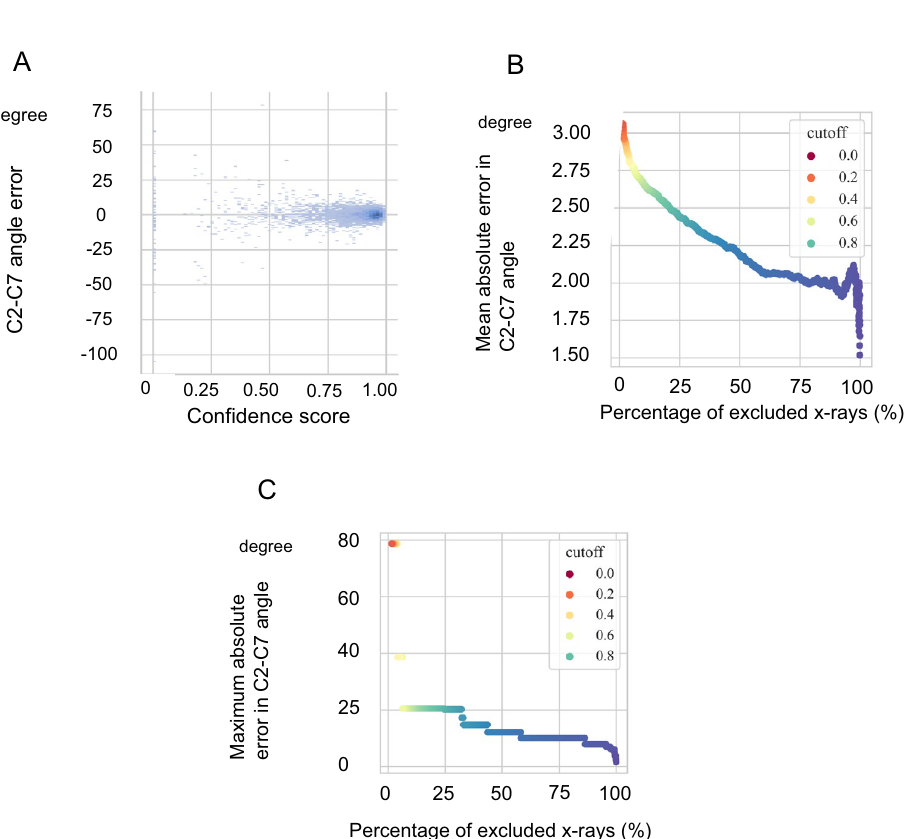
Figure 5. ( A ) Scatter plot showing the relationship between the confidence score and the error at the C2– C7 angle. The smaller the confidence score, the larger the error. ( B ) Relationship between the percentage of excluded x-rays and mean absolute error at the C2–C7 angle when the cutoff value of the confidence score is changed. Increasing the threshold reduces the error but increases the number of x-rays to be excluded. ( C ) Relationship between the percentage of excluded x-rays and maximum absolute error at the C2–C7 angle when the cutoff value of the confidence score is